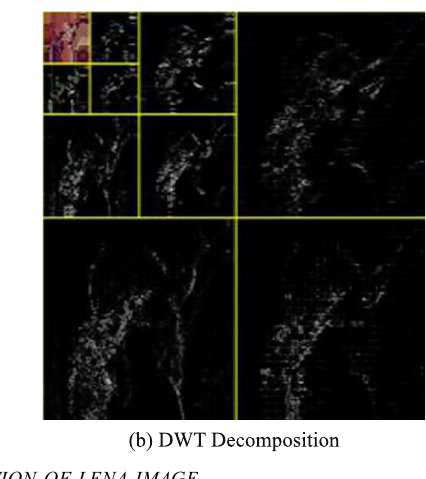
FIG. 1. THREE LEVEL DWT DECOMPOSITION OF LENA